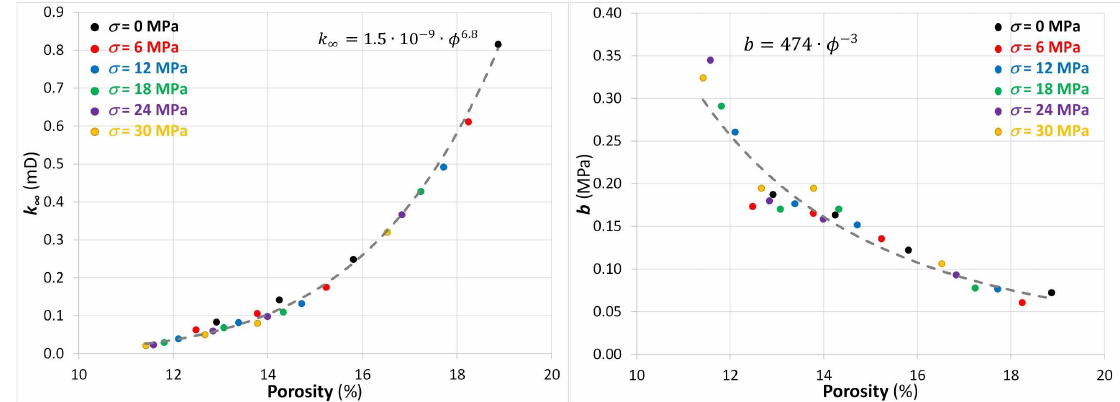
Figure 7. The relationships between the values of the Klinkenberg permeability coefficient k ∞ , and the slippage factor b , as a function of the porosity, obtained from the tests on the coal samples N1–N4 using nitrogen, where: σ —are the stress values; φ —is the porosity.